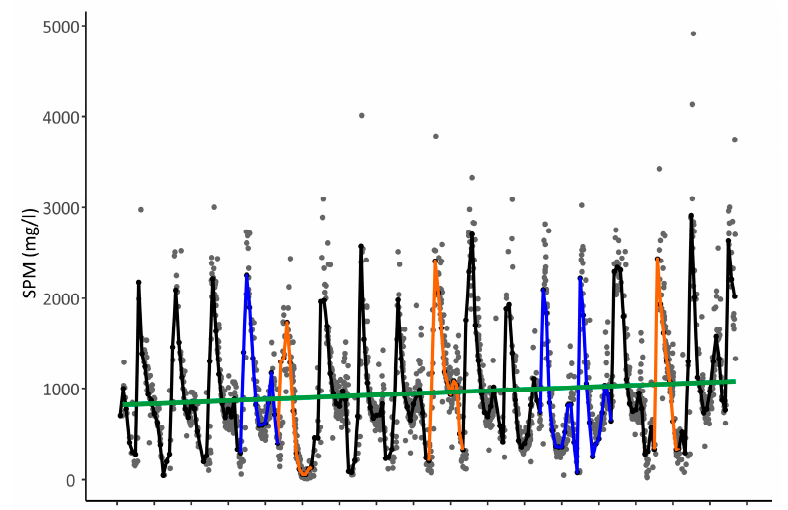
Figure 10. SPM time series (gray dots), monthly means (black for normal years, orange for the three driest years, and blue for the three wettest years) derived from MODIS daily data, and the trend over the 2000–2016 period (green).